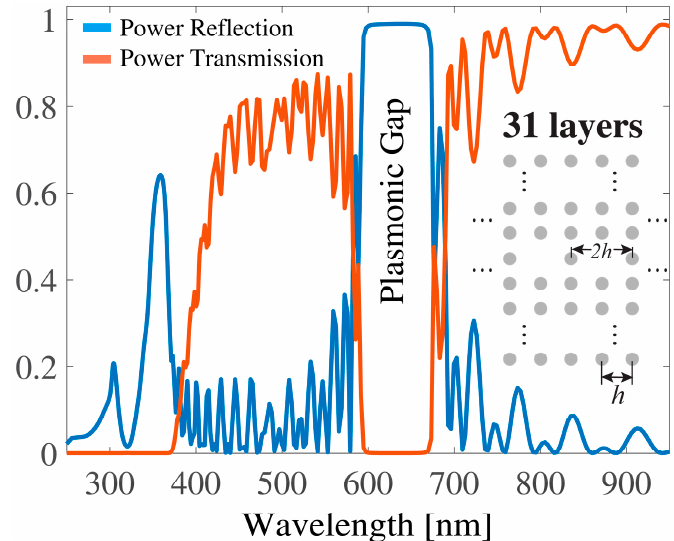
Figure 2. The same settings as in Figure 1, except that the intermediate 16th layer of the original crystal was replaced by a defect layer where one nanocylinder was periodically removed with a period of 2h .